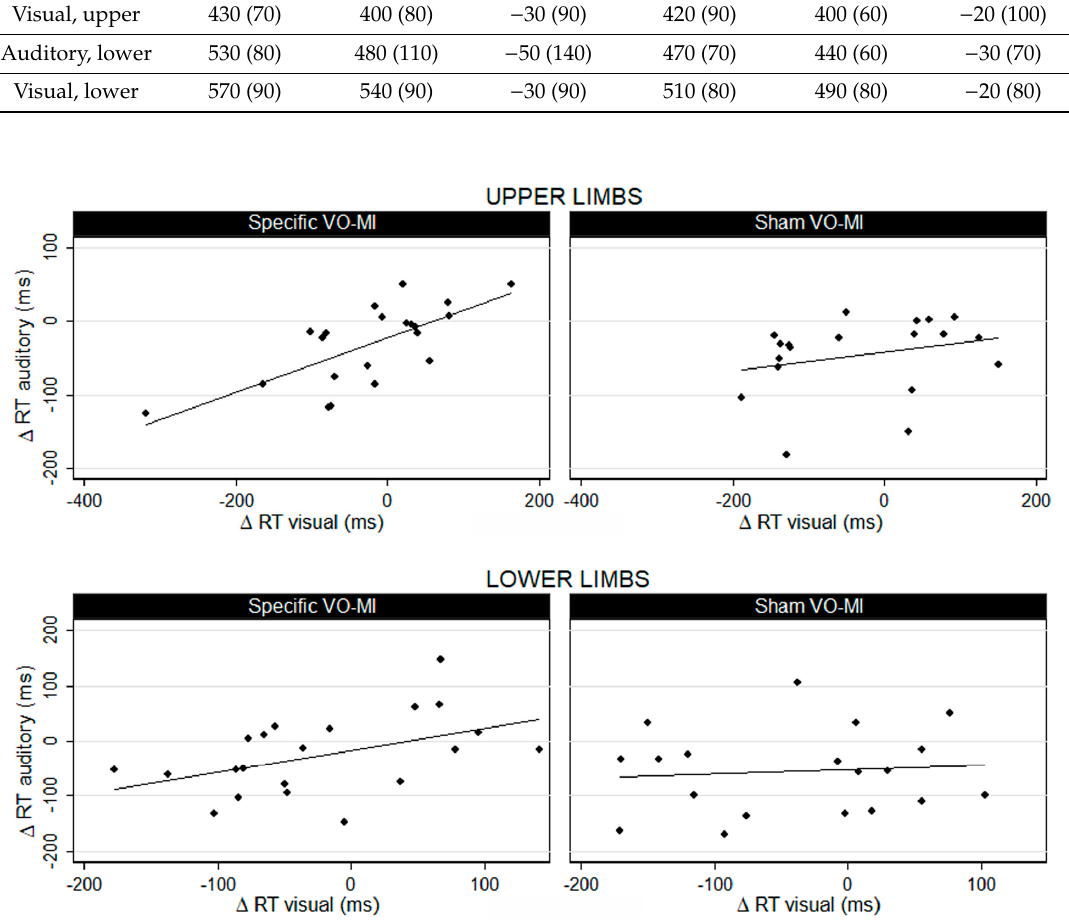
Figure 2. Correlation between the reduction in the reaction time ( Δ RT) to visual and auditory stimuli for upper and lower limbs in the experimental (specific VO/MI) and control (sham VO/MI) groups.